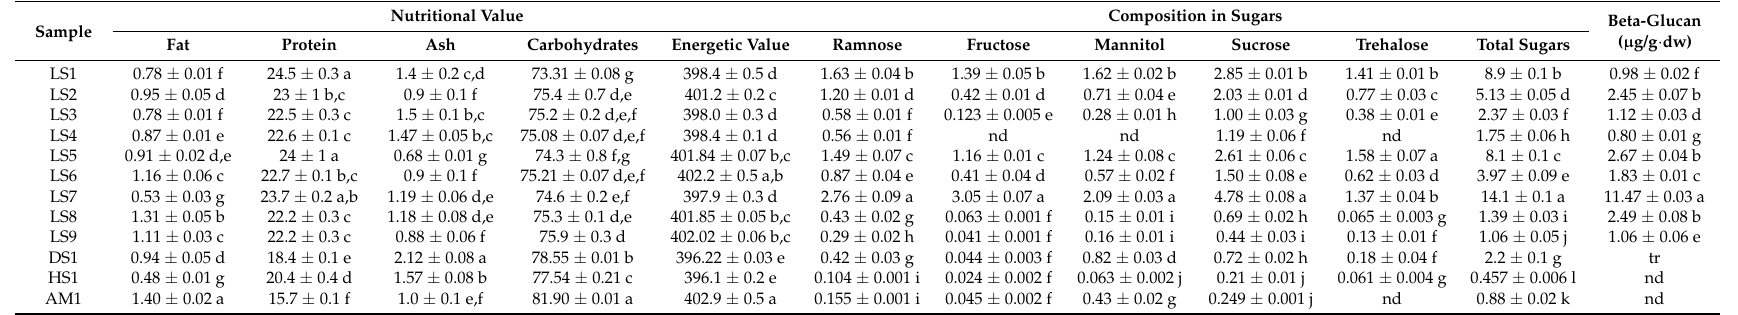
Table 1. Nutritional value, sugars and beta-glucan composition of the studied wild